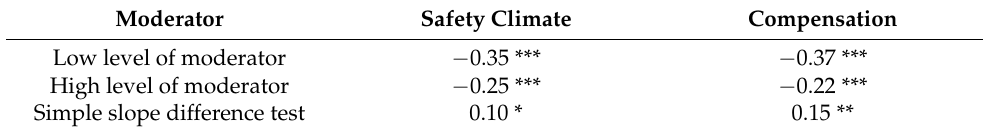
Table 5. Simple slope